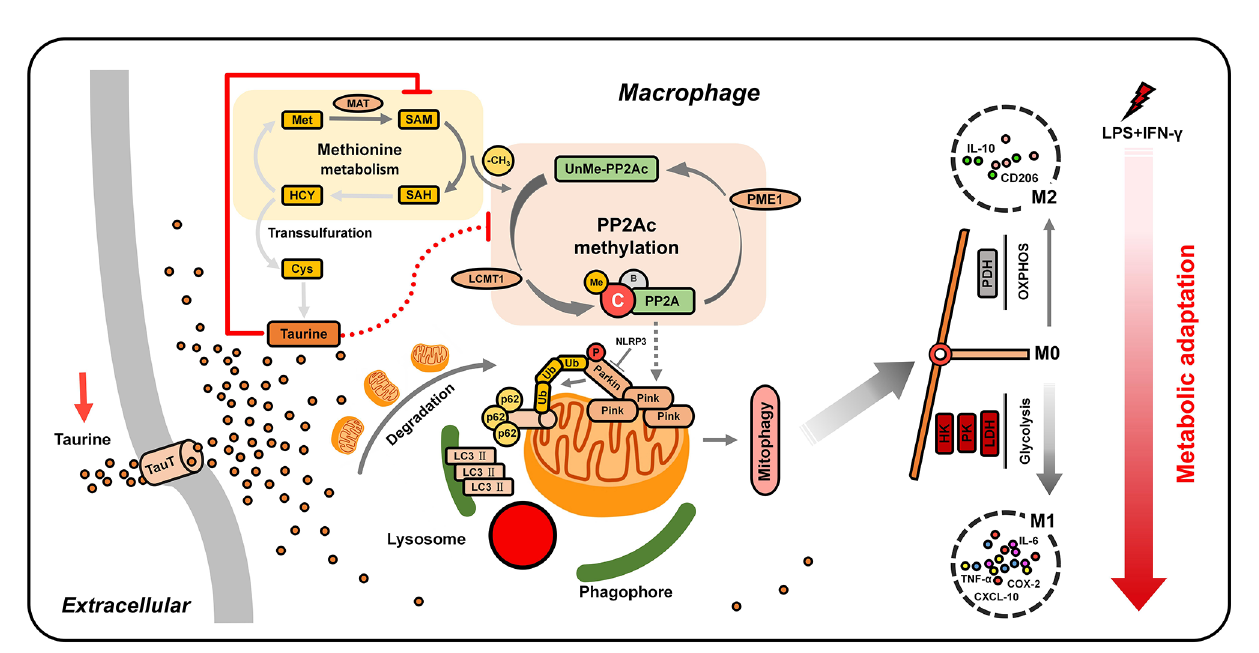
FIGURE 7 | Working model. LPS/IFN- g -challenged macrophages trigger PINK1-mediated mitophagy by activating SAM-dependent PP2Ac methylation to eliminate mitochondria. This promotes a metabolic switch toward glycolysis, thus realizing the metabolic adaptation of macrophages to pro-in fl ammatory M1 polarization. The nutrient uptake signal TauT supports the massive in fl ux of taurine after supplementation, which limits the synthesis of SAM. The low availability of SAM is sensed by LCMT-1 and PME-1, hindering PP2Ac methylation. The blocking of PP2Ac methylation negatively regulates the connection between mitochondrial autophagy and glycolysis, ultimately weakening M1